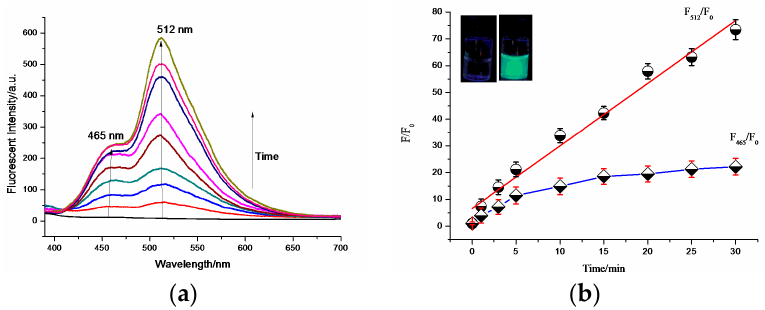
Figure 1. ( a , b ) Time-dependent fluorescent spectral changes of PHBT under UV irradiation (0 – 30 min) at room temperature, PHBT dissolved in PBS buffer (10 mM, pH 7.4, water/DMSO = 99:1) to form 10 µM testing solution, with excitation λ = 365 nm. (inset) Change in the fluorescence of the probe ( left ) before and ( right ) after UV irradiation (30 min) at room temperature.